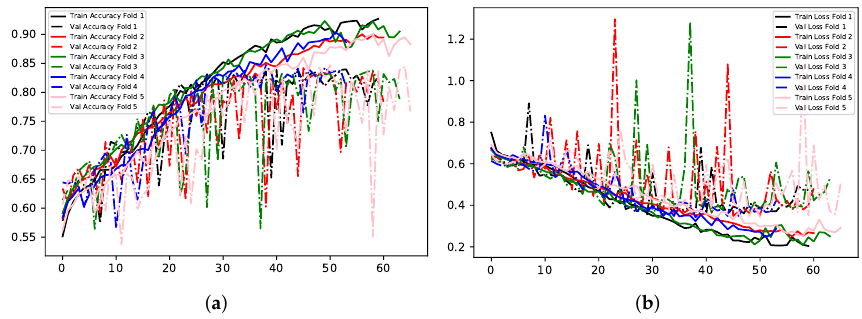
Figure 16. Model C Experiment 2 Results. ( a ) Accuracy. ( b ) Loss.